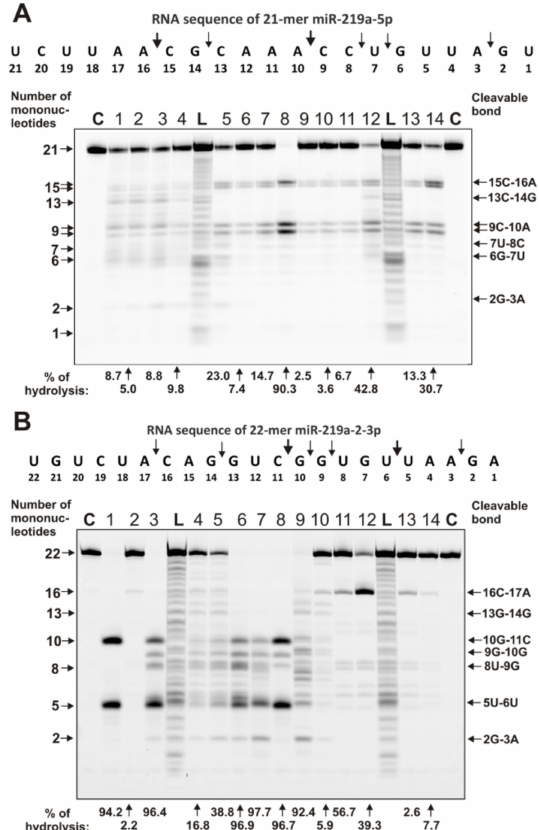
Figure 3. The patterns of cleavage of oligonucleotides Flu-miR-219-2-5p ( A ) and Flu-miR-219-2-3p ( B ) by IgGs (0.6 µ M IgGs; 1 h of incubation) from sera of 14 different MS patients. The products of splitting were detected due to the fluorescent residue (Flu) on the 5 (cid:48) -ends of the oligonucleotides. Lane C corresponds to ONs incubated in the absence of Abs, whereas Lanes L corresponds to the length of oligonucleotide markers. The numbers of IgG preparations, lengths of the products, and the percentage of microRNA cleavage by each IgG preparation are shown in panels ( A , B